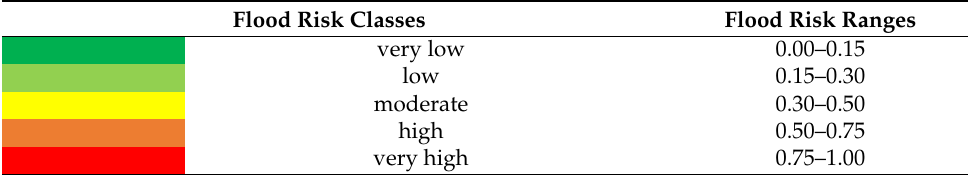
Table 3. Qualitative range of flood risk